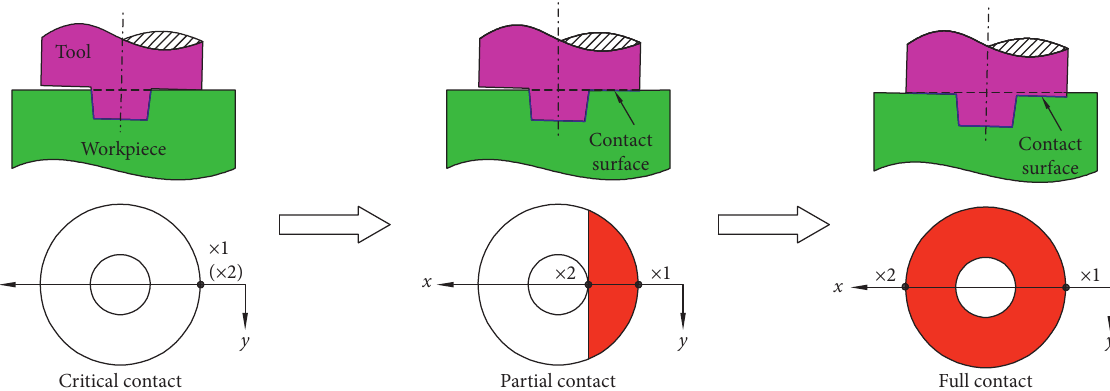
Figure 12: Contact conditions between the shoulder and workpiece in the shoulder-plunging stage at different steps in the MAM.